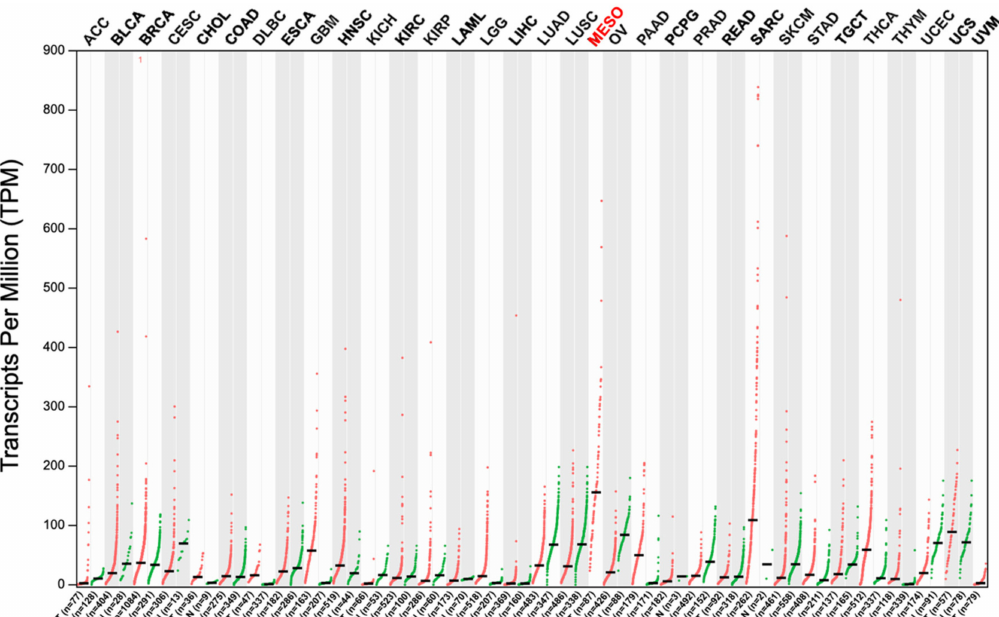
Figure 1. The gene expression profile of MRC2. TCGA data have been adapted from the GEPIA web server [20,21]. Dot plots (mRNA levels) across tumor samples are shown in red. MESO represents malignant mesothelioma [18]. For most tumors (although not for MM), data for their normal tissue of origin are also shown in green. The median values are indicated with bars. For the abbreviations of the analyzed cancer types, see Table